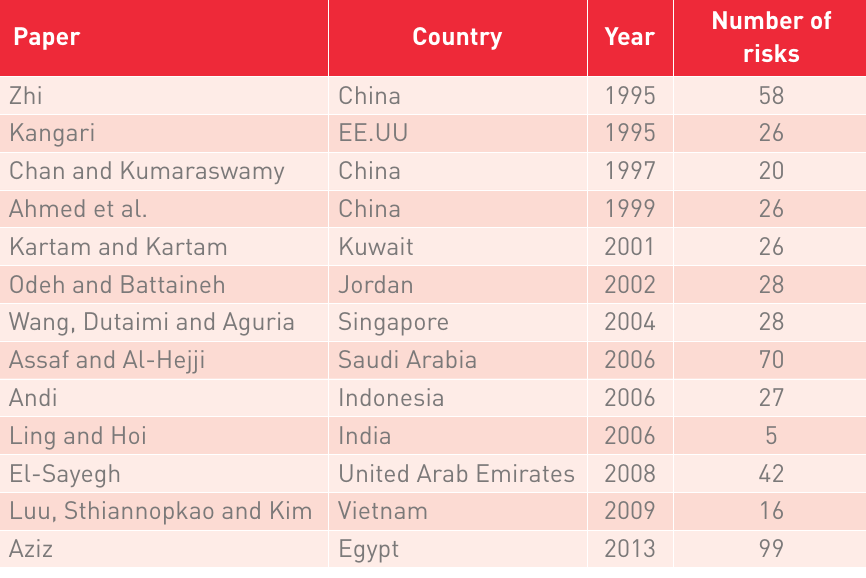
Relevant literature related to risk